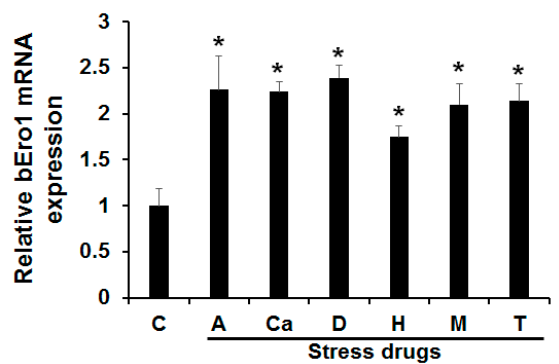
Figure 3. Effects of various endoplasmic reticulum stresses on bEro1 expression. Bm5 cells were treated with 8 μ M antimycin (A), 10 μ M calcium inophore A23187 (Ca), 3 mM dithiothreitol (D), 100 μ M H 2 O 2 (H), 100 μ M monensin (M), and 5 μ g/mL of tunicamycin (T) for 4 h. (C) indicates the control without ER stress reagent. Relative expression levels are presented as the mean ± SD ( n = 3); * p < 0.05 versus control.